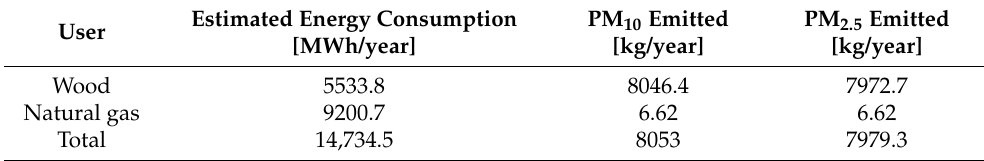
Table 8. PM 10 and PM 2.5 emissions obtained by replacing wood and gas